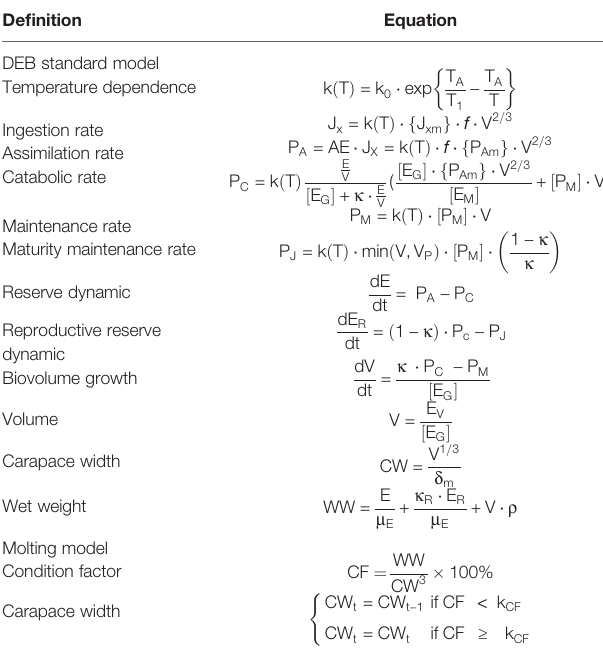
TABLE 1 | Equations describing the discontinuous individual growth model of the swimming crab Portunus trituberculatus . De fi nition